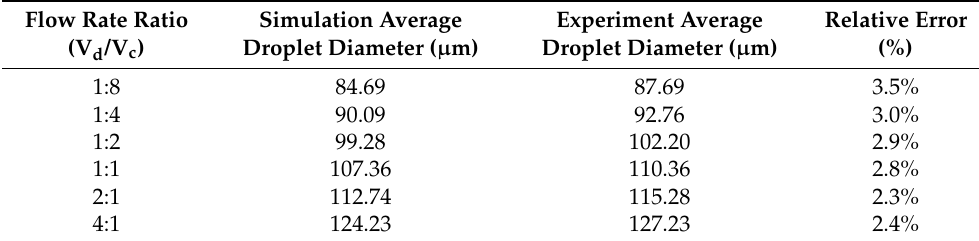
Table 3. Simulation and experimental data of droplet diameter under six different flow rate ratios ( N = 6).